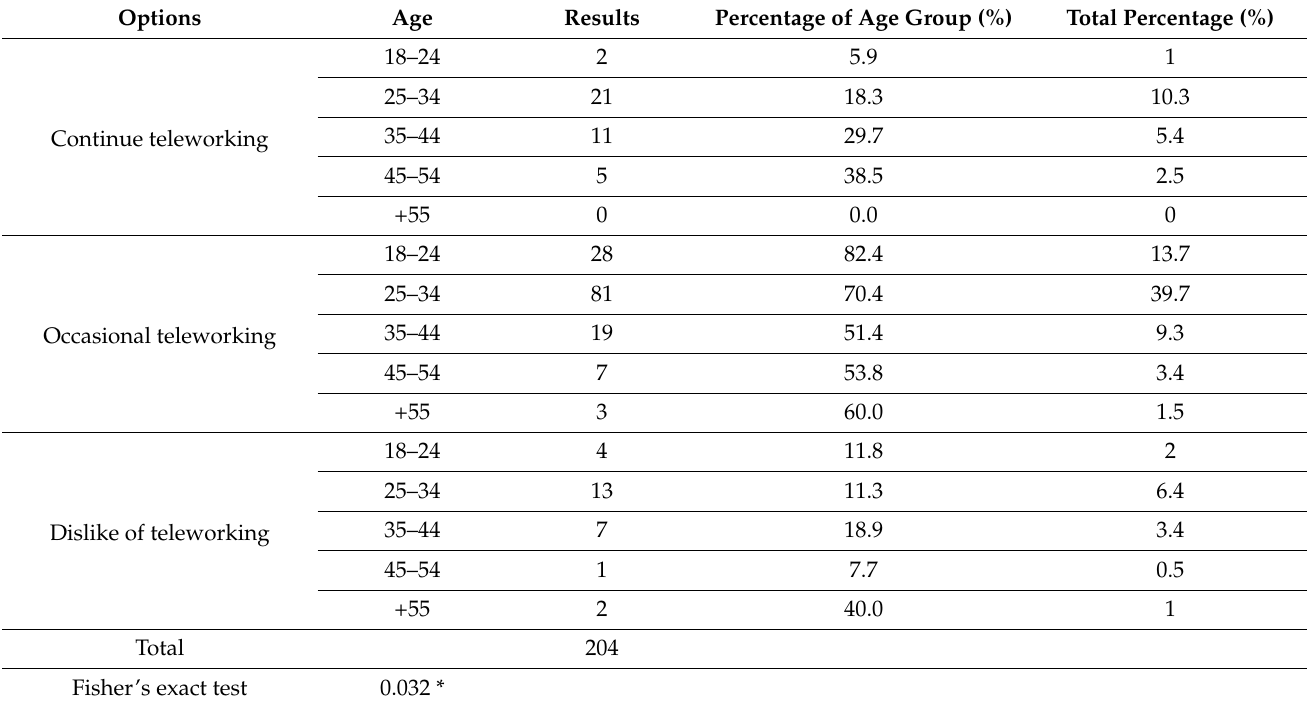
Table 3. Interest in teleworking modality related to